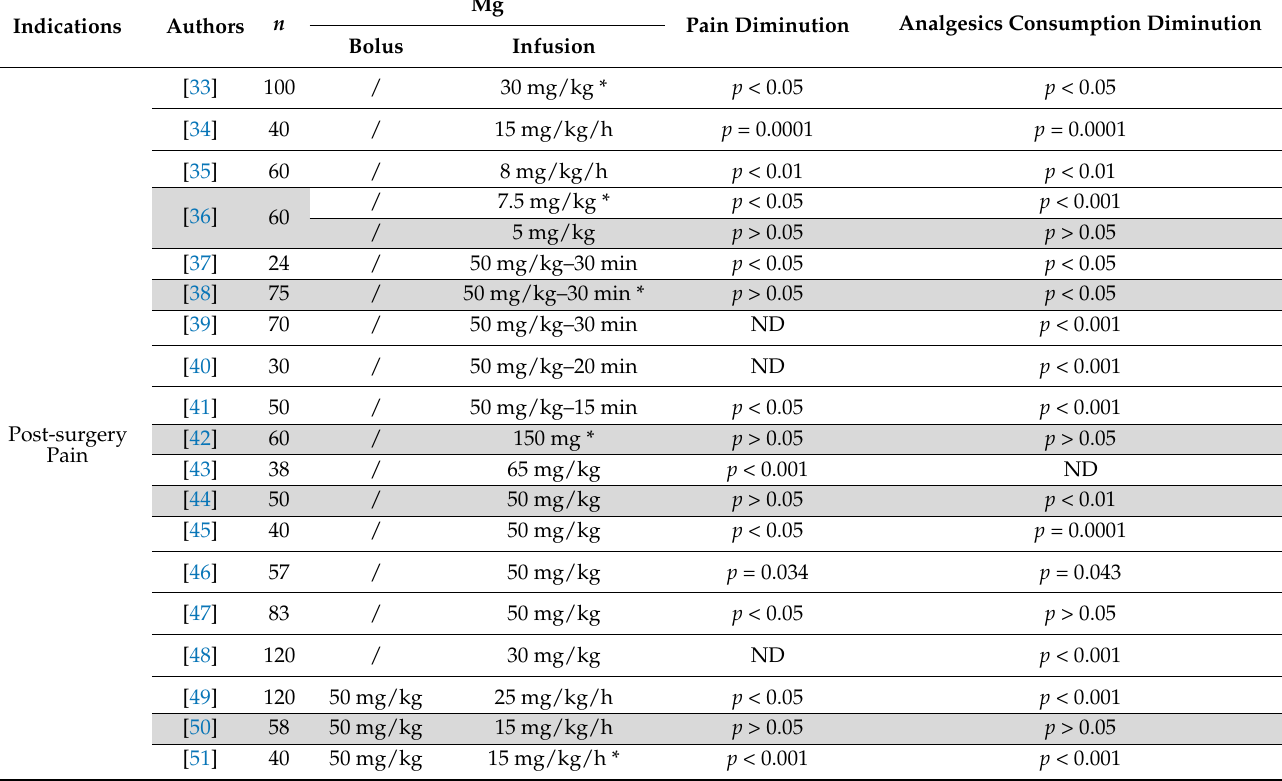
Table 1. Randomised clinical trials evaluating the effect of intravenous magnesium sulphate on pain and analgesics consumption compared to controls in different pain situations. Studies are versus (vs.) placebo, double-blind and in parallel groups unless specified. “ND”: not determined; * not double-blind; CrO: cross-over. The bolus corresponds to the first post-operative injection, followed by an infusion according to the protocol. Negative studies are with a grey highlight.